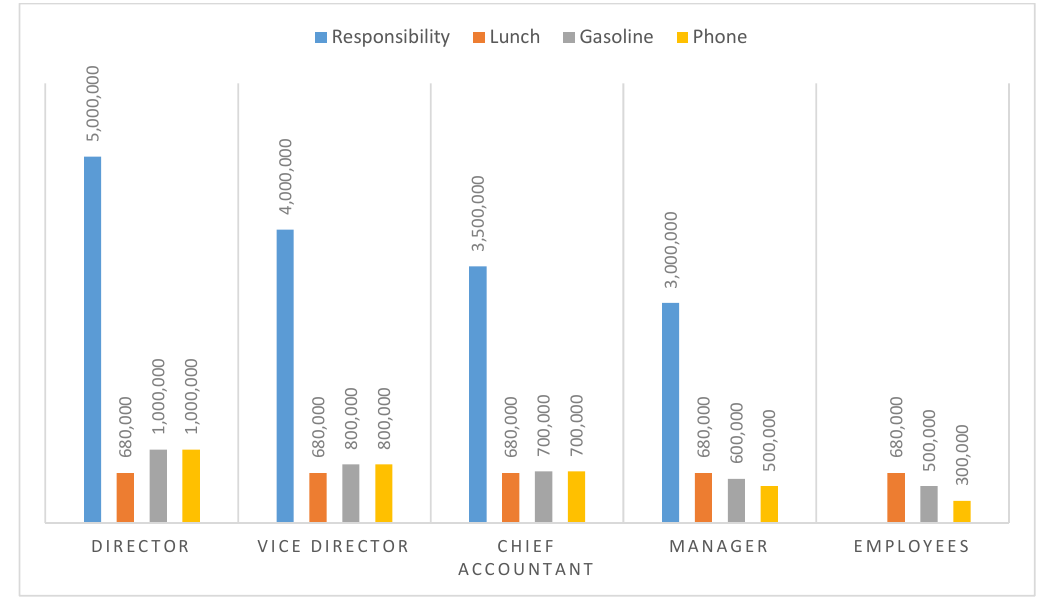
Fig. 5. Regulation of allowances (Unit: VND